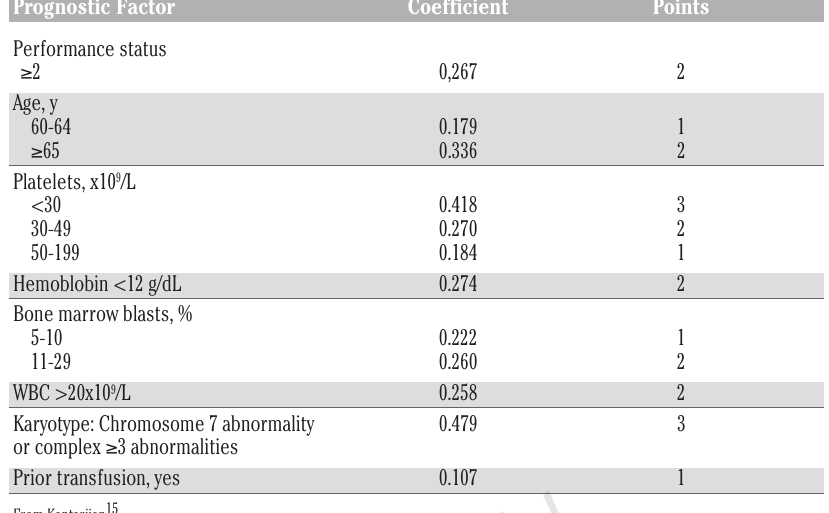
Table 1. Simplified myelodysplastic syndrome risk score (0-15